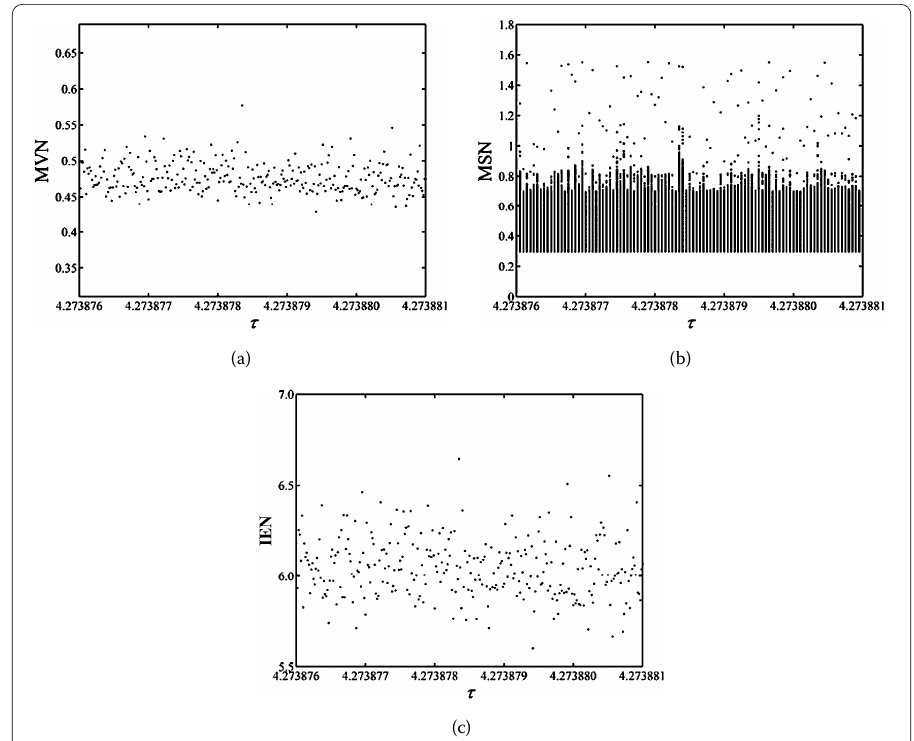
Figure 12 Graphs of ( a ) MVN, ( b ) MSN, and ( c ) IEN corresponding to the pattern transition with the variation of τ covering [4.273876,4.273881], suggesting a property of self-similarity in the pattern fluctuation. The conditions for pattern simulations are exactly the same as those in Fig.